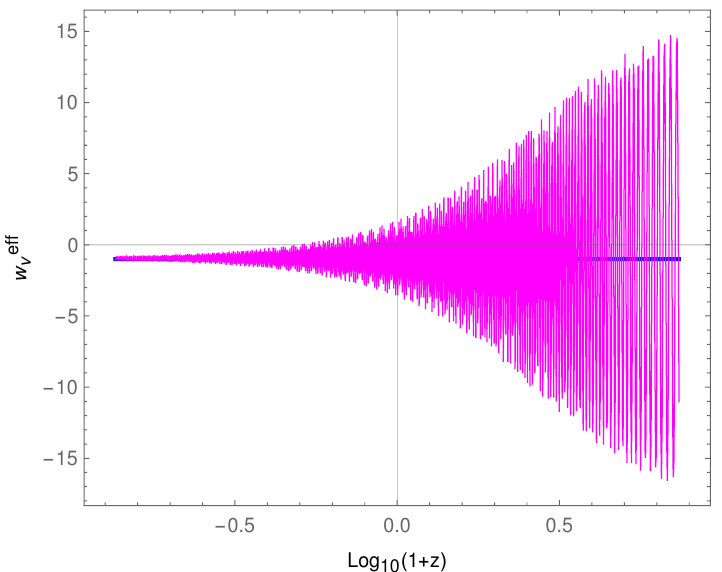
Figure 7. Evolution of w eff ν versus the red shift in case of the generalised exponential potential (69) for n = 3 and αγ = 1000, compatible with observation [115]; solid blue line corresponds to w eff ν = − 1. Figure shows that w eff ν oscillates and eventually settles close to minus one.